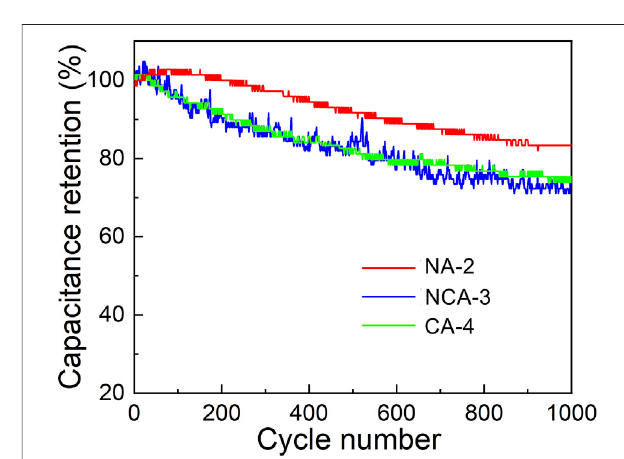
FIGURE 11 | Long-term cycling stability under a current density of 3 A g − 1 for the NA-2, NCA-3, and CA-4 samples.